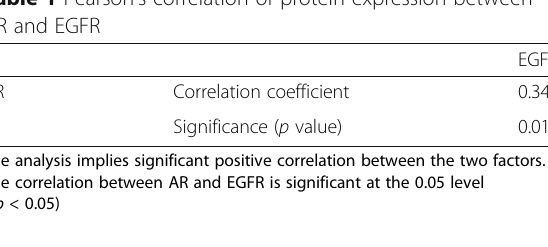
Table 2 Spearman ’ s correlation of mRNA expression between